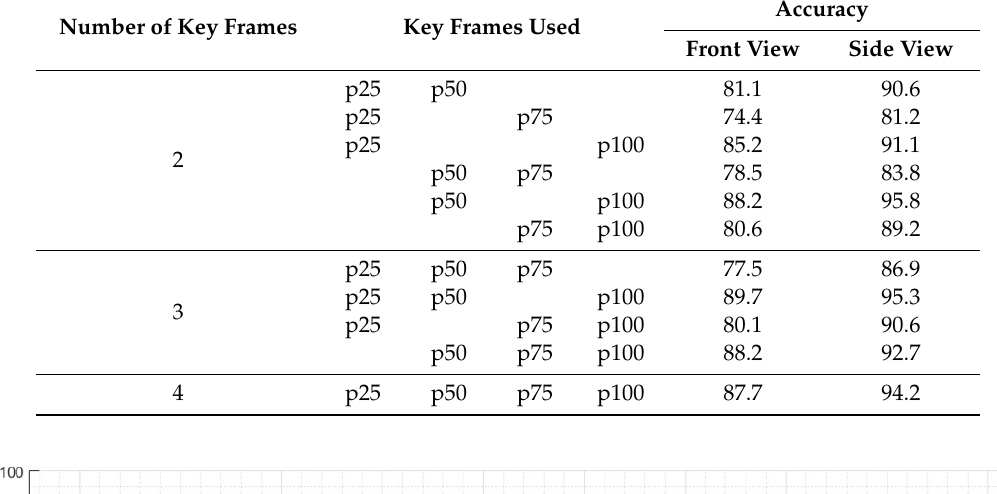
Table 5. Recognition accuracy according to key frames.